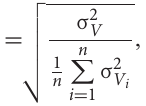
where w X and σ X were the half voltage and slope,